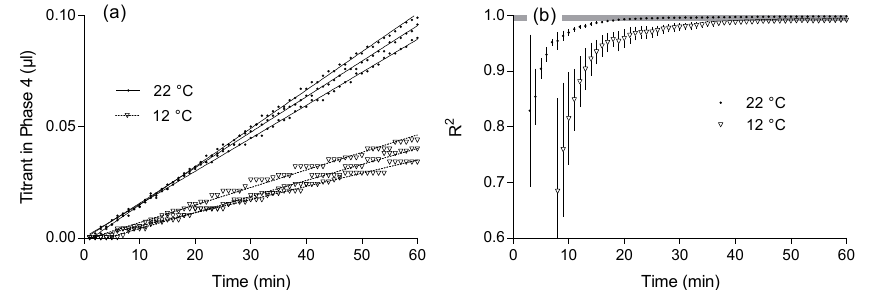
Figure 4. ( a ) Addition of titrant (0.01 mol · L − 1 NaOH solution) during the 60 min lasting hydrolysis of PLA (3 g · L − 1 ) by protease from Bacillus licheniformis (2.4 AU · mL − 1 ). ( b ) Progressive approximation of the coefficient of variation to R 2 = 0.99 (indicated by a grey bar).